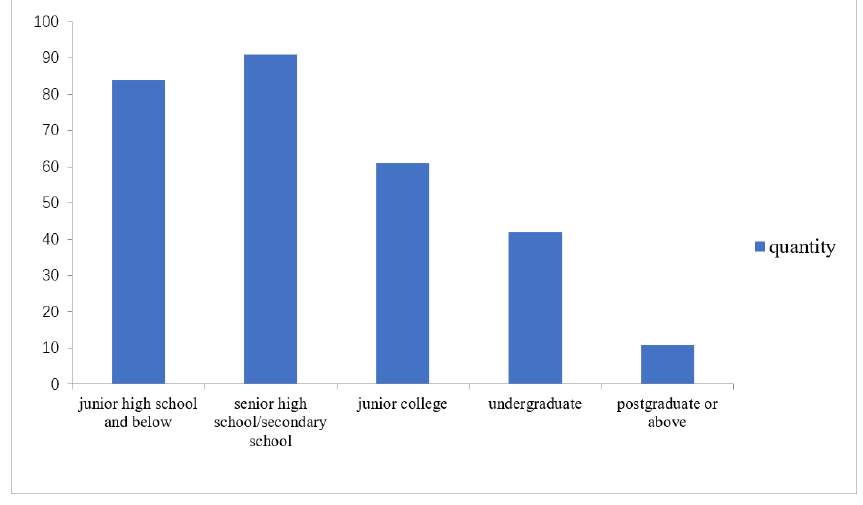
Fig. 2 Educational level of parents.